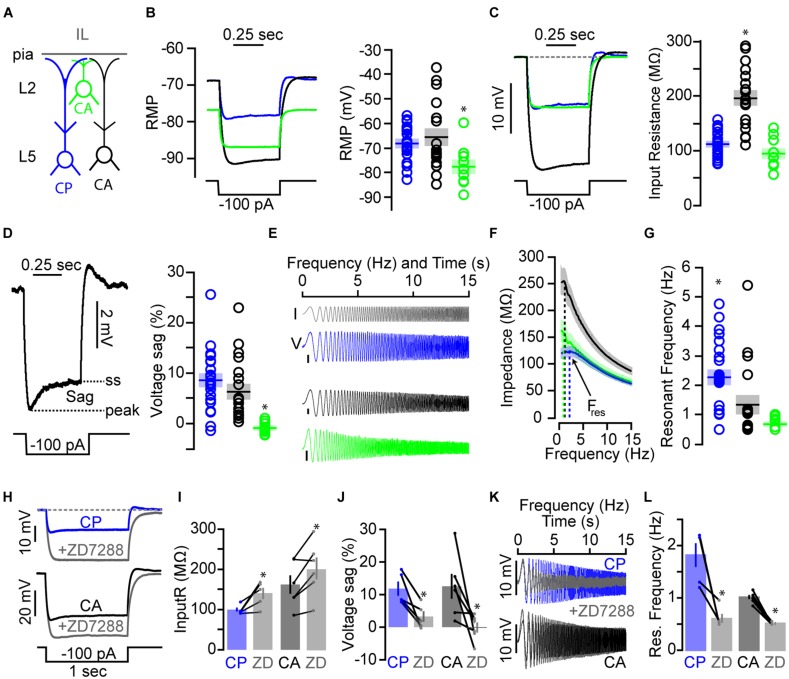
Subthreshold physiology differs between CP and CA neurons in IL (A) Schematic showing the subclasses of neurons recorded (CP, cortico-PAG; CA, cortico-BLA; L2, layer 2; L5, layer 5). (B, left) Average traces of subthreshold responses for each neuronal subclass. (B, right) Mean (±SEM) resting membrane potential (RMP) for CP (n = 26), L3/5 CA (n = 20), and L2 CA (n = 10) neurons (∗p < 0.05, Kruskal–Wallis test). (C, left) Subthreshold traces aligned to RMP showing the differences in input resistance. (C, right) Mean (±SEM) input resistance across projection class (∗p < 0.05, one-way ANOVA). (D, left) Subthreshold voltage response displaying a sag in the membrane potential before reaching a steady state (ss) level. (D, right) Mean (±SEM) voltage sag % across projection class (∗p < 0.05, Kruskal–Wallis test). (E) Chirp current (I) stimulus (gray) and examples of chirp voltage (V) responses for CP, L3/5 CA, and L2 CA neurons. Only the first 15 s of the sweeps are shown. Scale bars = 5 mV. (F) Average impedance profiles (ZAPs) with dashed lines denoting resonant frequency (Fres). (G) Mean (±SEM) resonant frequency across projection class (∗p < 0.05, Kruskal–Wallis test). (H) Subthreshold response of a CP (top) and L3/5 CA (bottom) neuron before and after addition of the Ih-blocker ZD7288 (10 μM). Effects of ZD7288 on (I) input resistance, (J) voltage sag, and (K,L) resonant frequency of CP (n = 5) and L3/5 CA (n = 6) neurons.